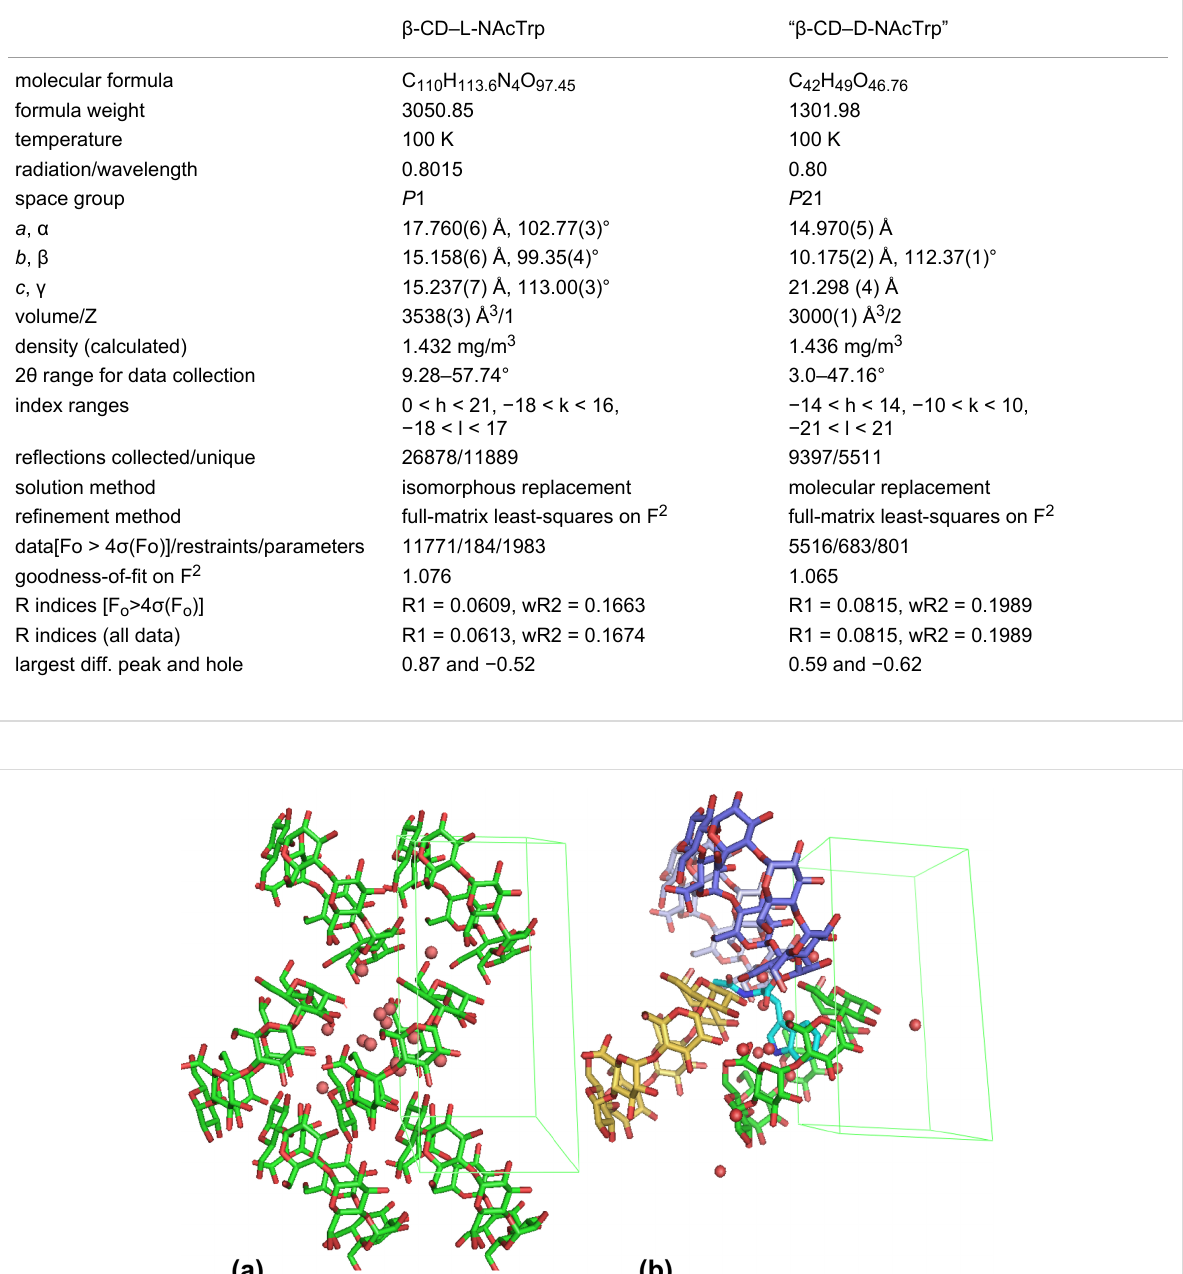
Table 2: Details of crystal and structure refinement data of the complexes. β -CD–L-NAcTrp and the β -CD–H2O (“ β -CD–D-NAcTrp”). β -CD–L-NAcTrp “ β -CD–D-NAcTrp”